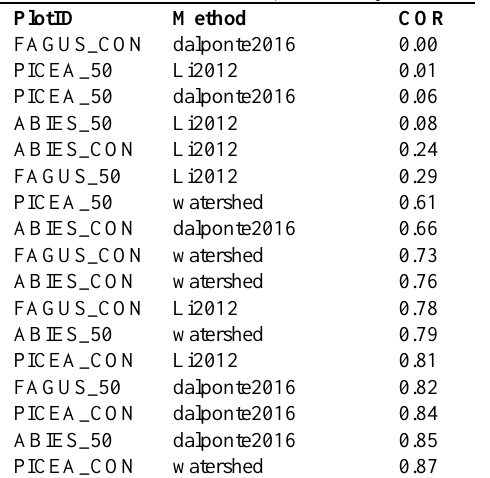
Table 2. COR=correlation (Pearson) values of F-Score and number of detected trees; ordered by COR values.